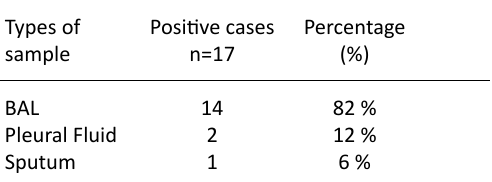
table 2. Sample wise distribution of positive cases